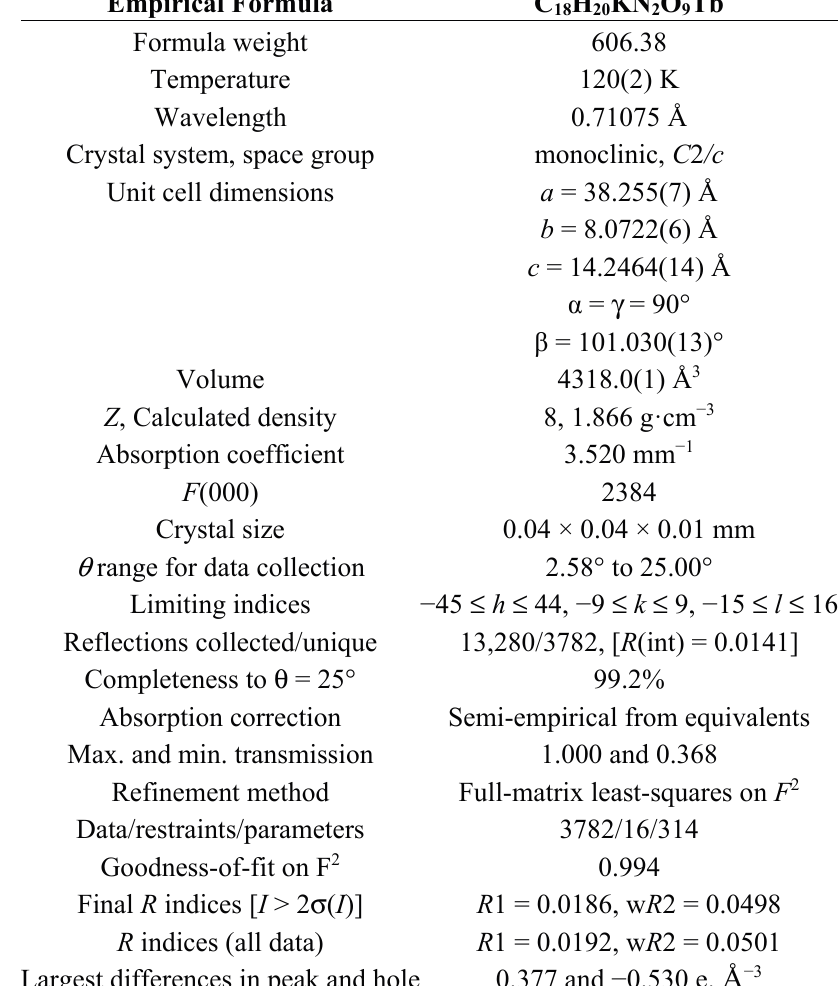
Figure 1. The crystallographically independent part of complex 2 . The O51A atom is disordered over two positions. The position with the higher occupancy factor (0.61) is displayed only owing to clarity. Table 1. Crystal data and structure refinement for complex 2